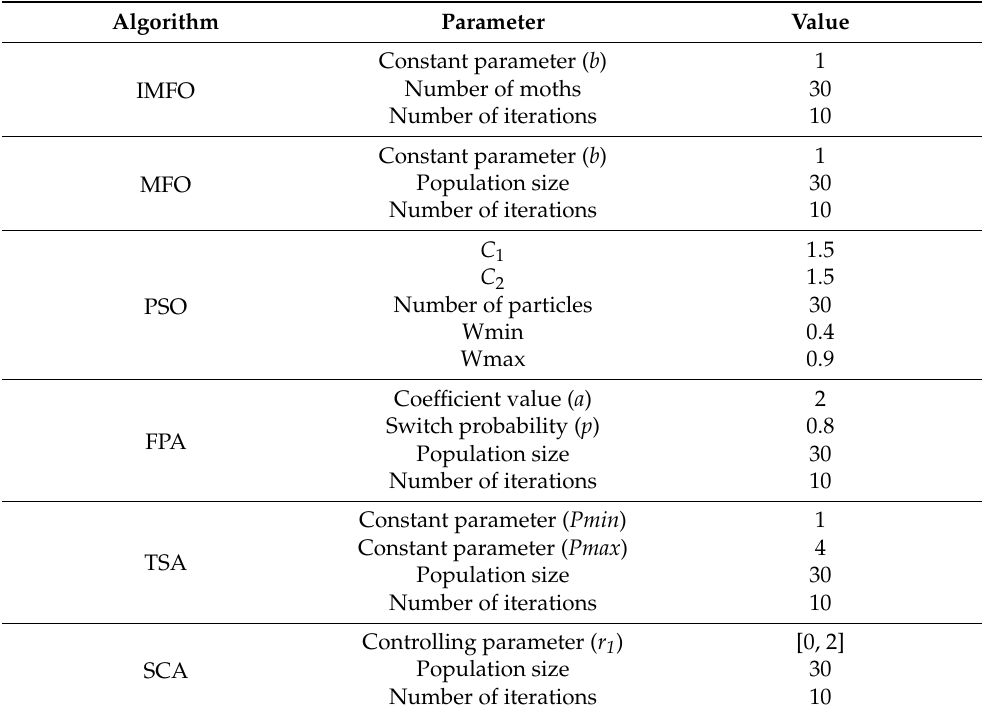
Table 1. The parameter configuration of all compared algorithms.